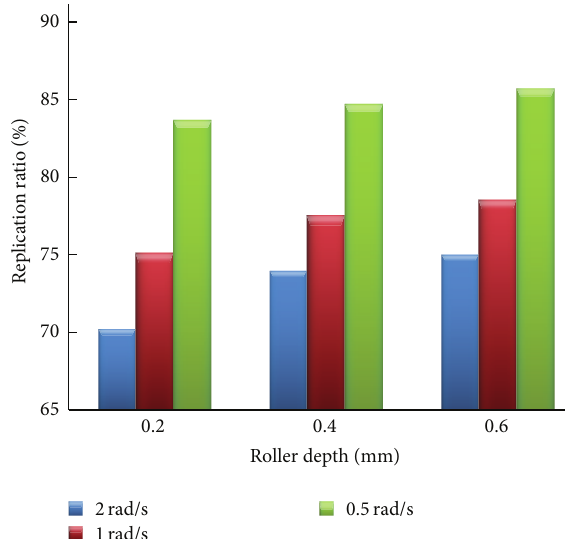
Figure 5: The changing chart in which replication rate changed with rolling temperature.